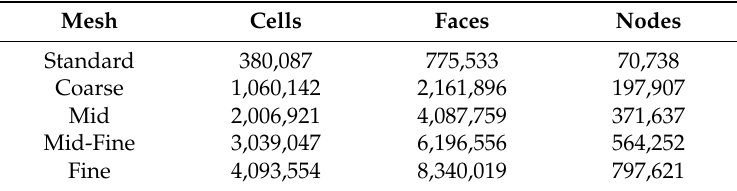
Table 3. Grids for the